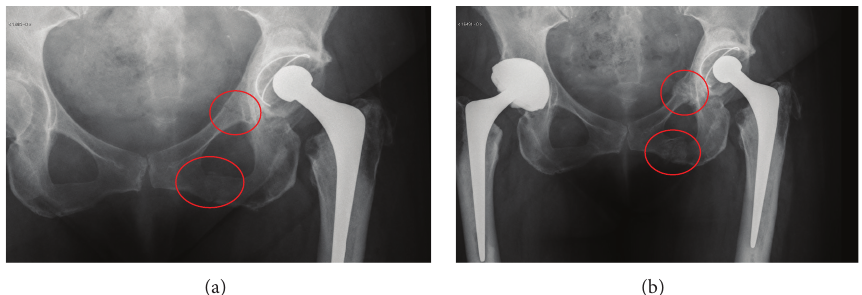
Figure 1: AP radiographs of the pelvis showing (a) bifocal pubic rami fractures at age 58; (b) healing fractures aged 61 (3 years later).